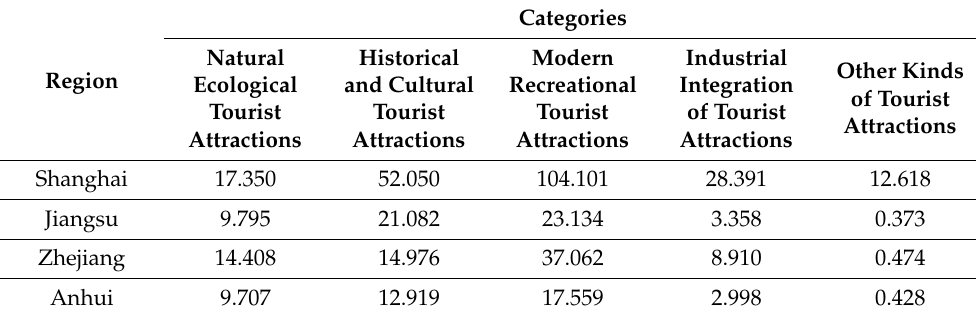
Table 2. The density of the five types of tourist attractions (per 10,000 km 2 ).